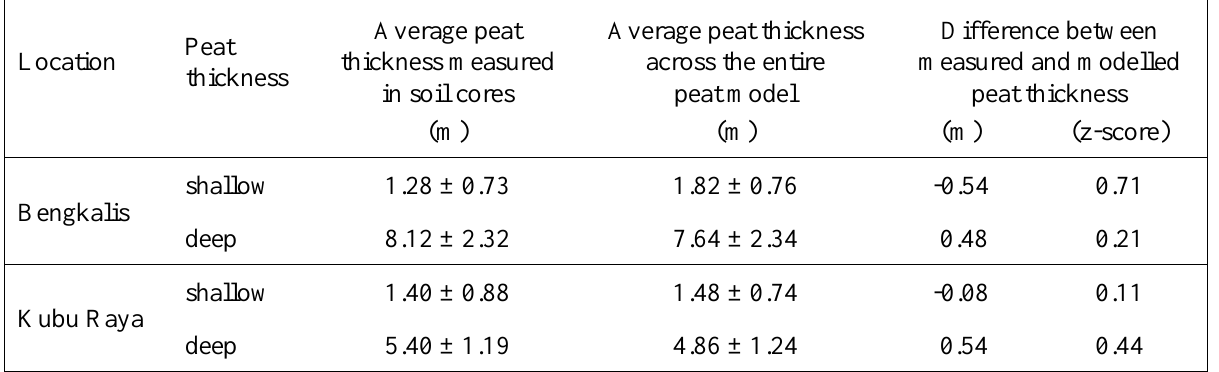
Table A4. Sampling error in the 3D peat